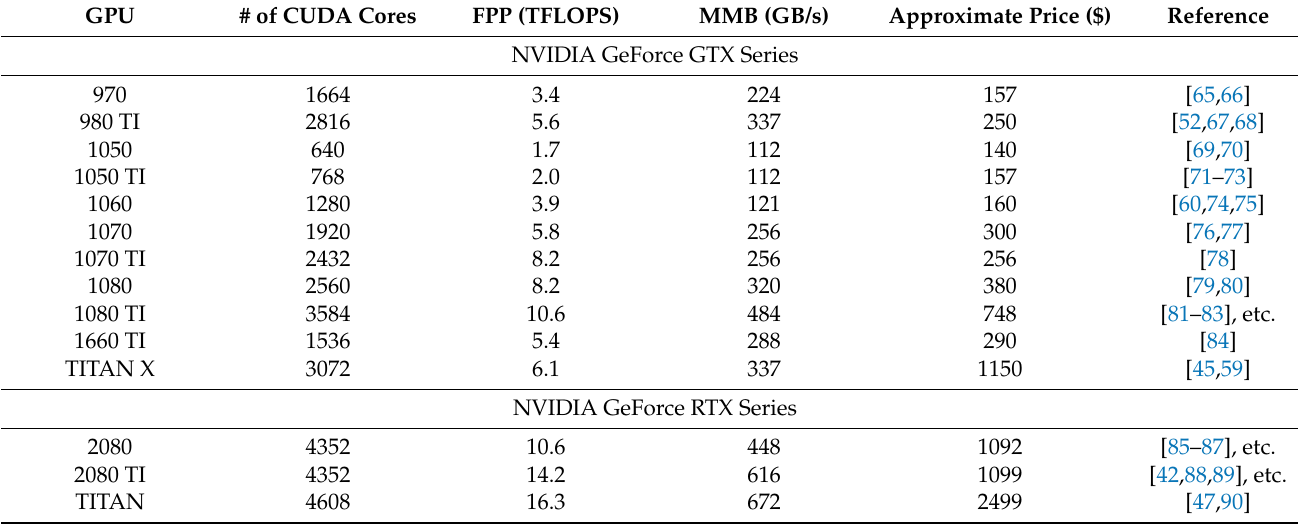
Table 1. Specifications and approximate price of GPU cards and corresponding